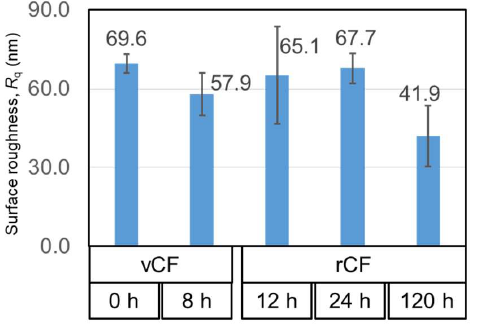
Figure 6. Surface roughness calculated in root mean square of vCF and rCF surface from the obser- vation area 2 μm × 2 μm. observation area 2 µ m × 2 µ